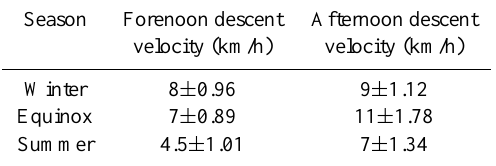
Table 1. Mean descent velocities of the intermediate